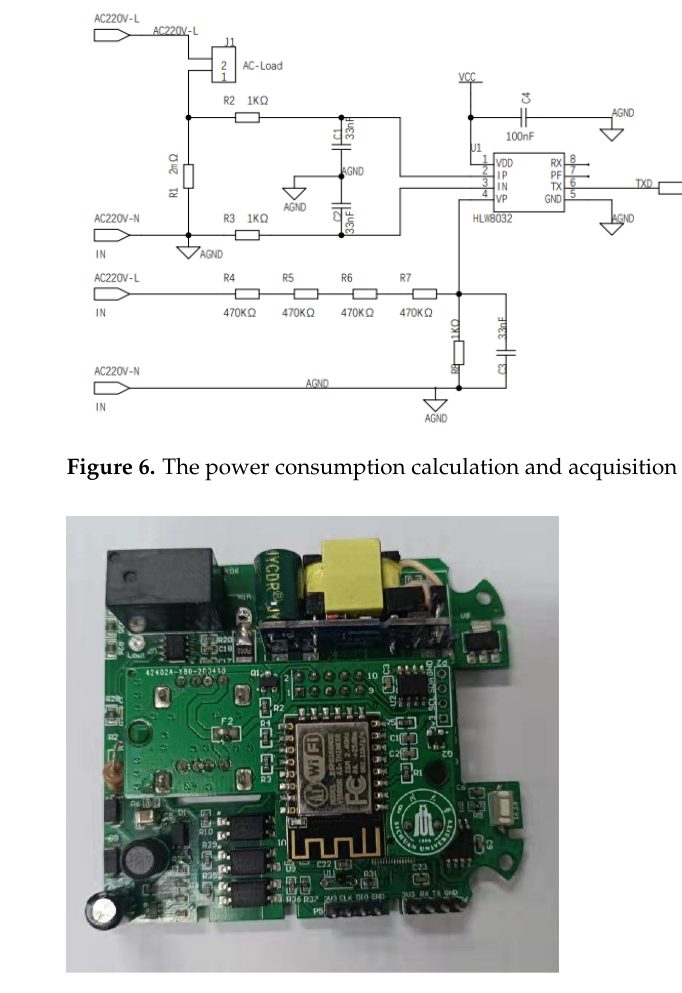
Figure 7. The circuit board of the power consumption calculation and acquisition